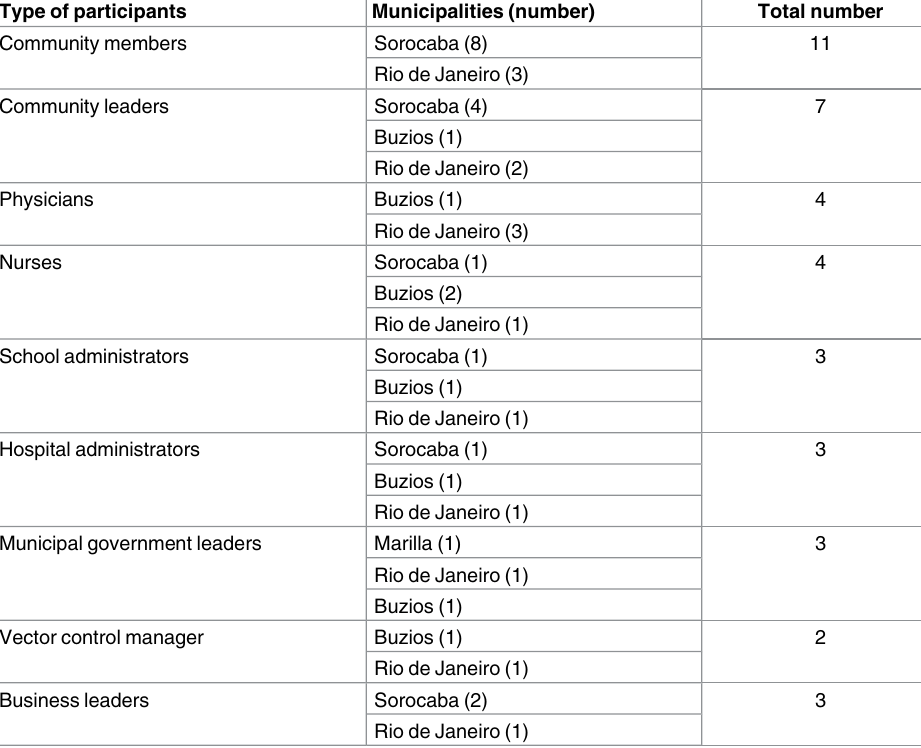
Table 1. Categories of stakeholders included in the study, April—August 2015,